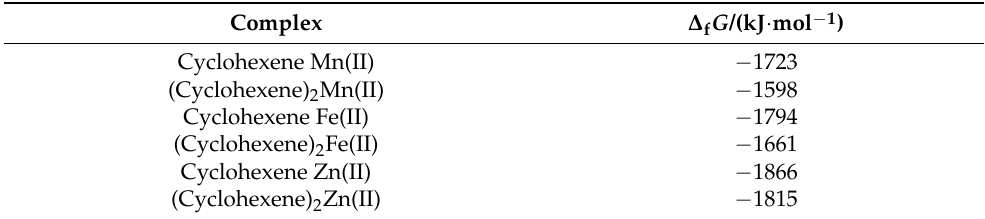
Figure 4. The privileged structure of the formed complex between single/double cyclohexene molecule and Fe 2+ , Mn 2+ , as well as Zn 2+ . ( a ) Fe 2+ and single cyclohexene molecule; ( b ) Fe 2+ and double cyclohexene molecules; ( c ) Mn 2+ and single cyclohexene molecule; ( d ) Mn 2+ and double cyclohexene molecules; ( e ) Zn 2+ and single cyclohexene molecule; and ( f ) Zn 2+ and double cyclohexene molecules. Table 2. The Gibbs free energy of the formed complex between single/double cyclohexene molecules and cations.